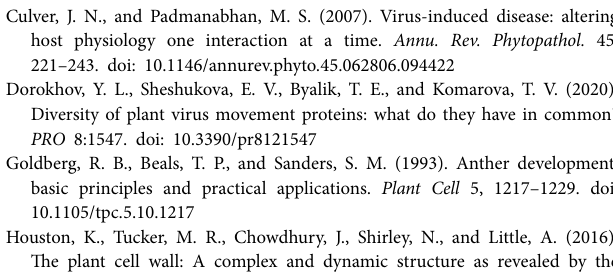
Supplementary Figure S1 | Toluidine-blue lignin histochemical analyses of the secondary cell walls of the inflorescence stems. The virus or buffer inoculum are indicated. Bars indicate 100 μ m. The cortex(co), xylem vessels (xv), and interfascicular fibres (if) are marked with letters. The results with Toluidine-blue reinforce those shown in Figure 2